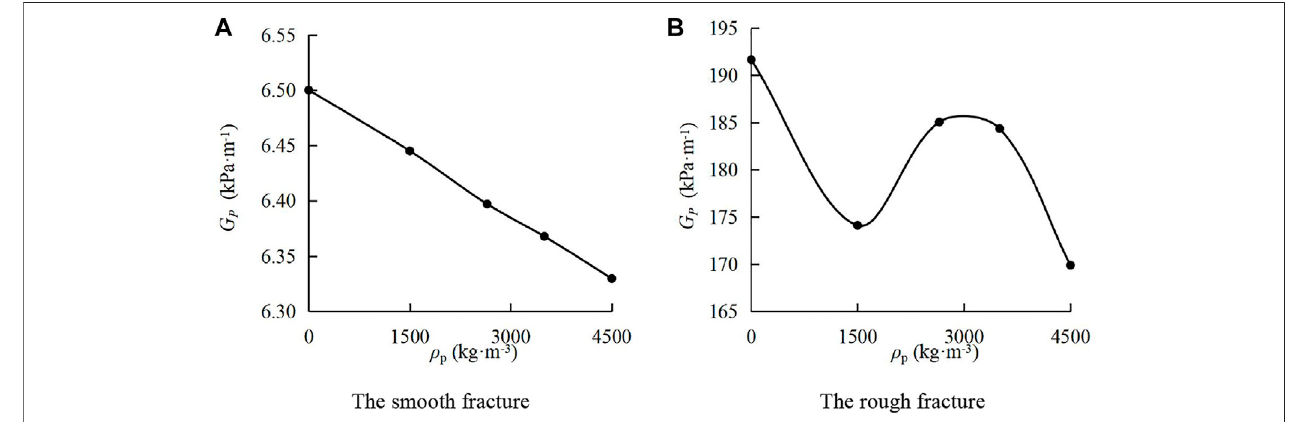
FIGURE 6 | Absolute value of the pressure gradient – sediment particle mass density curves. (A) Smooth fracture; (B) rough